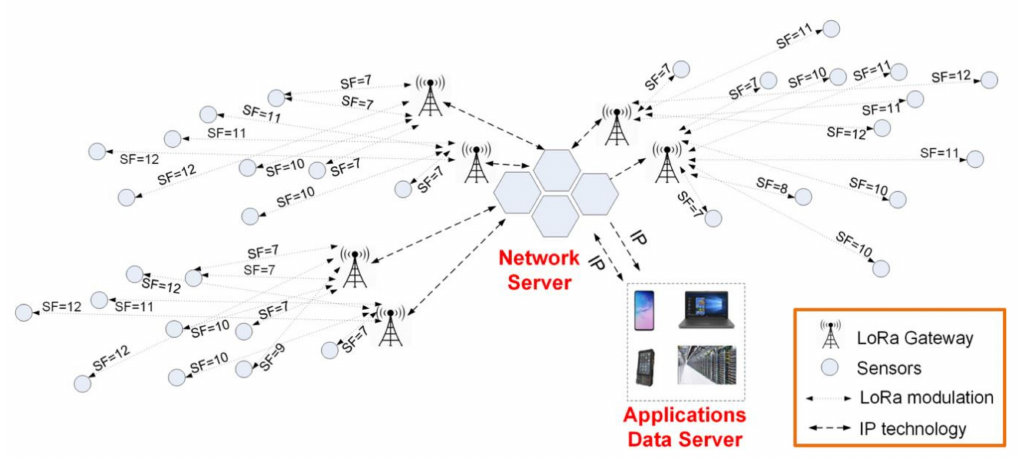
Figure 2. LoRaWAN architecture. It consists of sensors, gateways, a network server to allow user applications to access field data and a server for the application’s